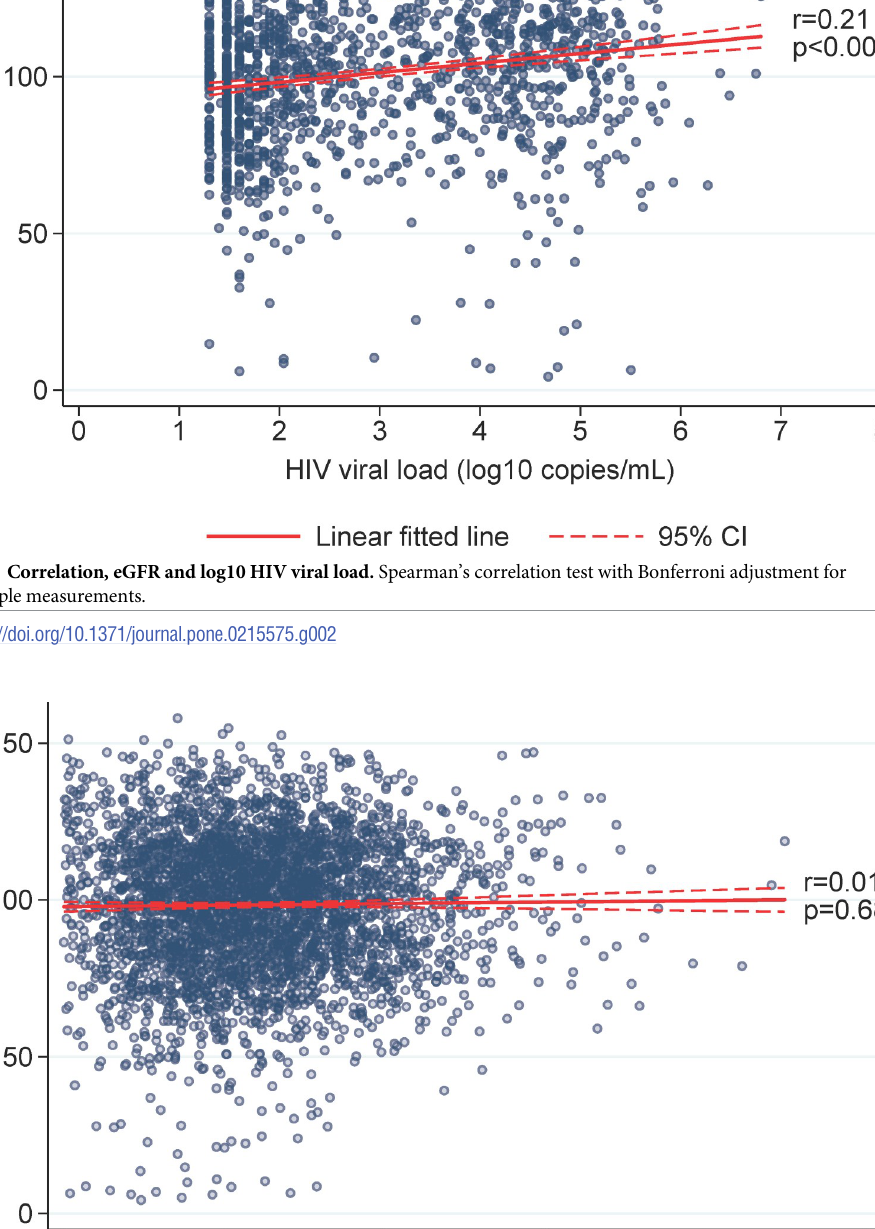
PLOS ONE | https://doi.org/10.1371/journal.pone.0215575 April 17,